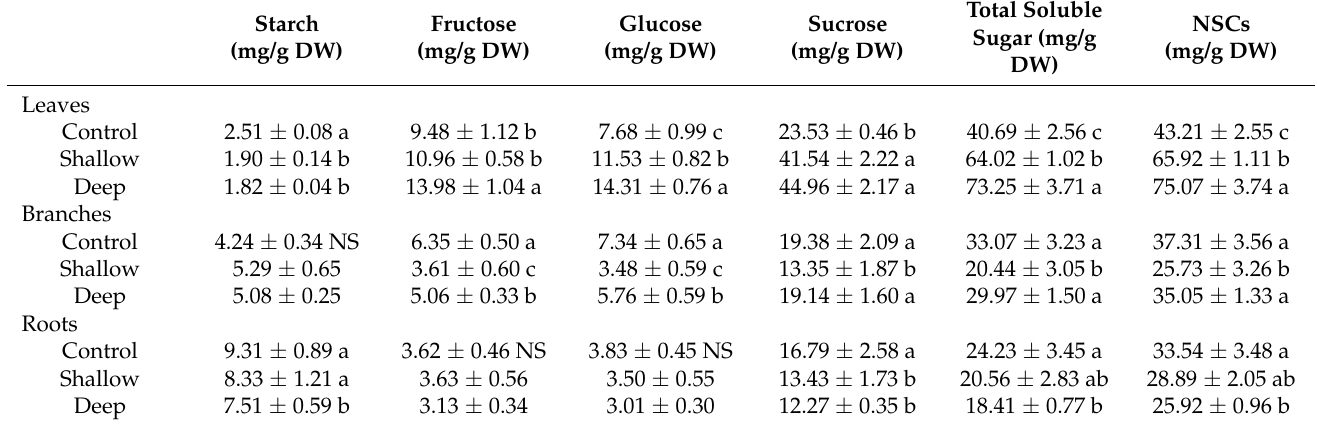
Table 2. Starch and soluble sugars in leaves, branches and roots sampled on 6 December 2019 subsequent to harvest intensity treatments of control, shallow cut (0.2 m above ground) and deep-cut (0.1 m above the ground), which were imposed on 28 December